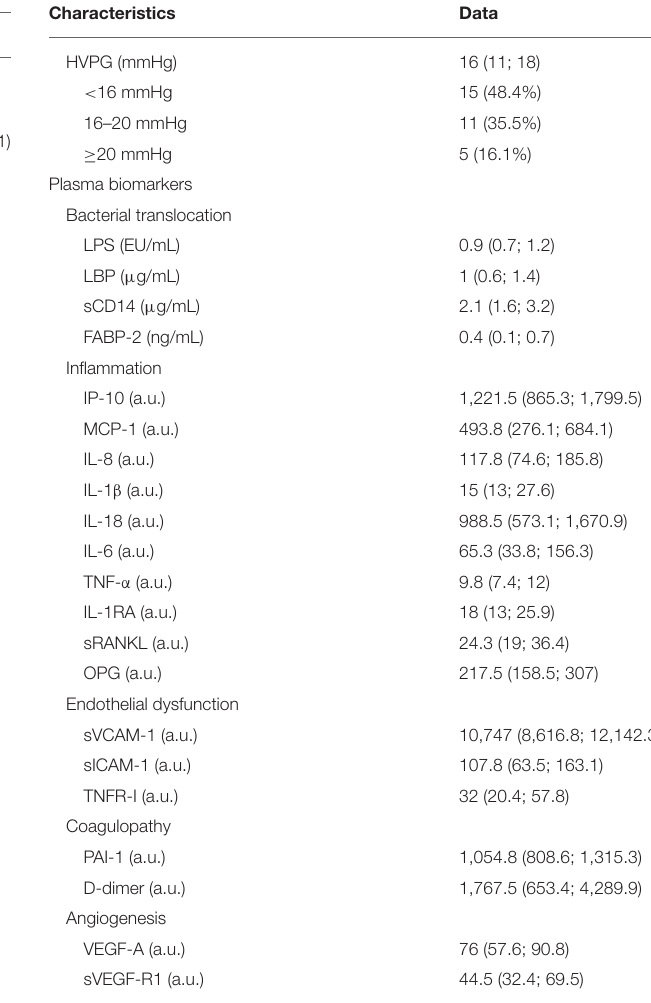
TABLE 1 | Summary of characteristics of HIV-infected patients with advanced HCV-related cirrhosis at baseline. Characteristics